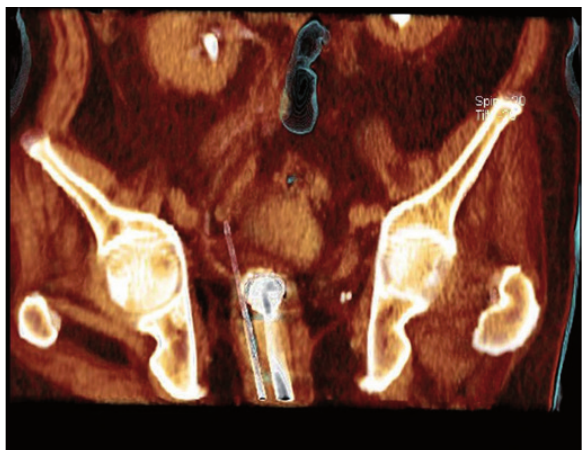
Figure 3 - Tomographic reconstruction positioning of the transrectal probe and biopsy needle to the target